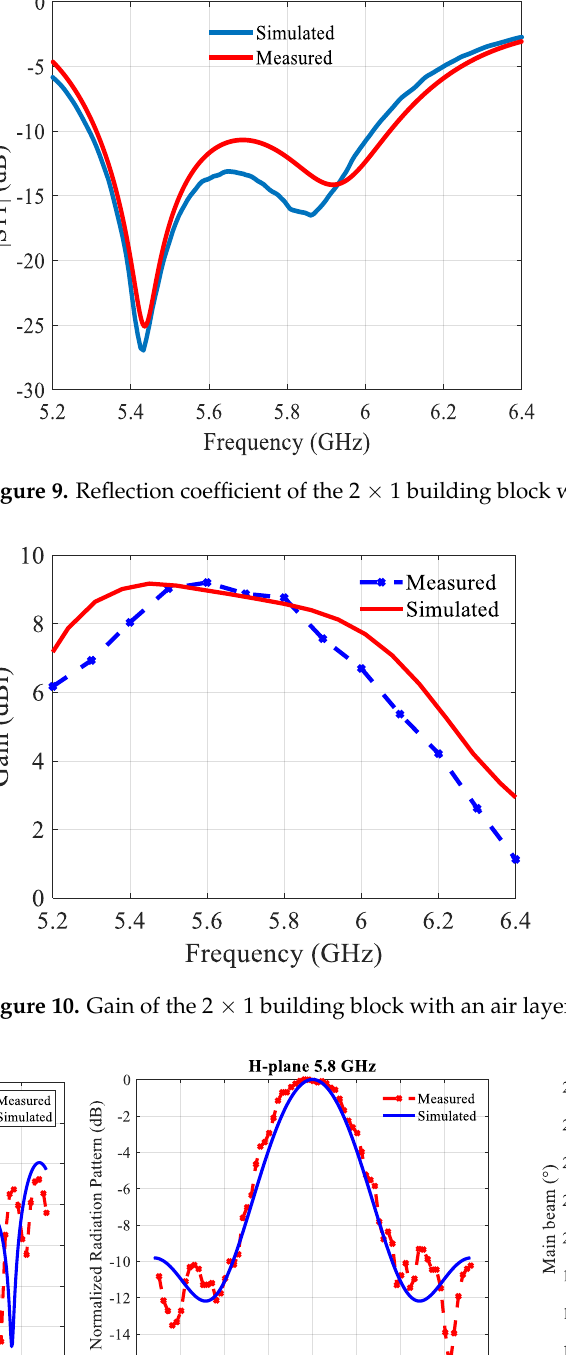
Figure 8. Configurations: ( a ) the 2 × 1 building block with an air layer ( b ) prototype of the 2 × 1 building block with an air layer.